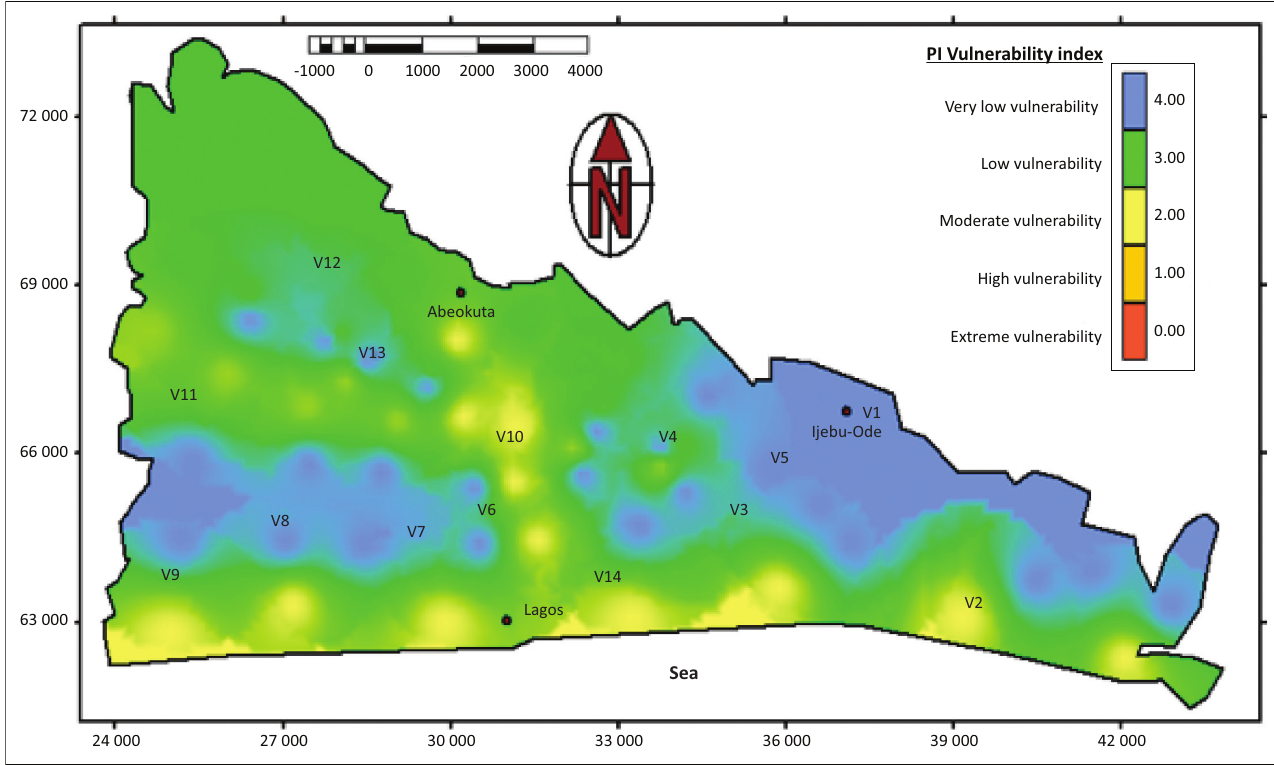
FIGURE 6: Validation map showing groundwater monitoring